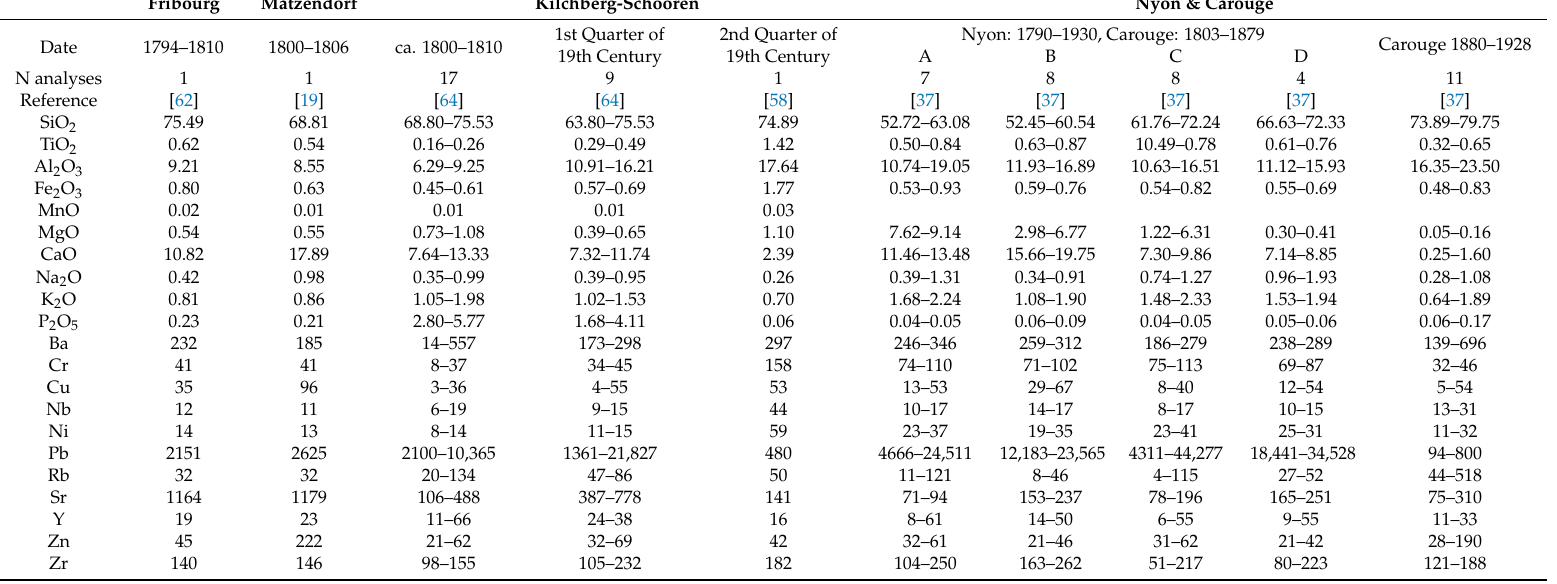
Table 6. Chemical compositions (XRF, Min.–Max.) of Swiss white earthenwares . Oxides in wt %, elements in